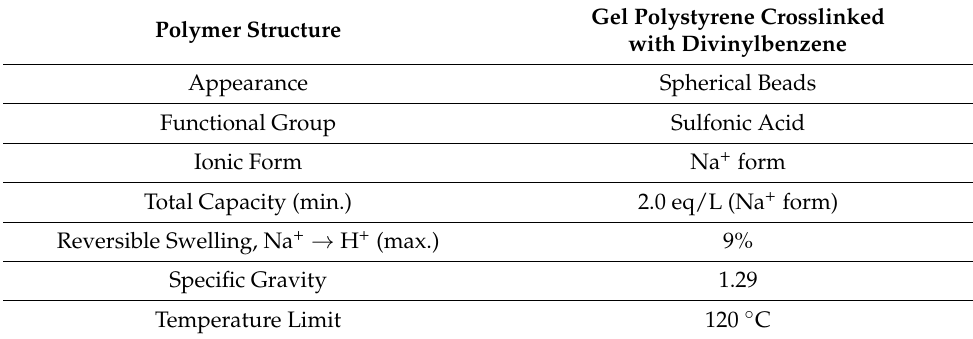
Table 1. The typical characteristics of the ion-exchange resin